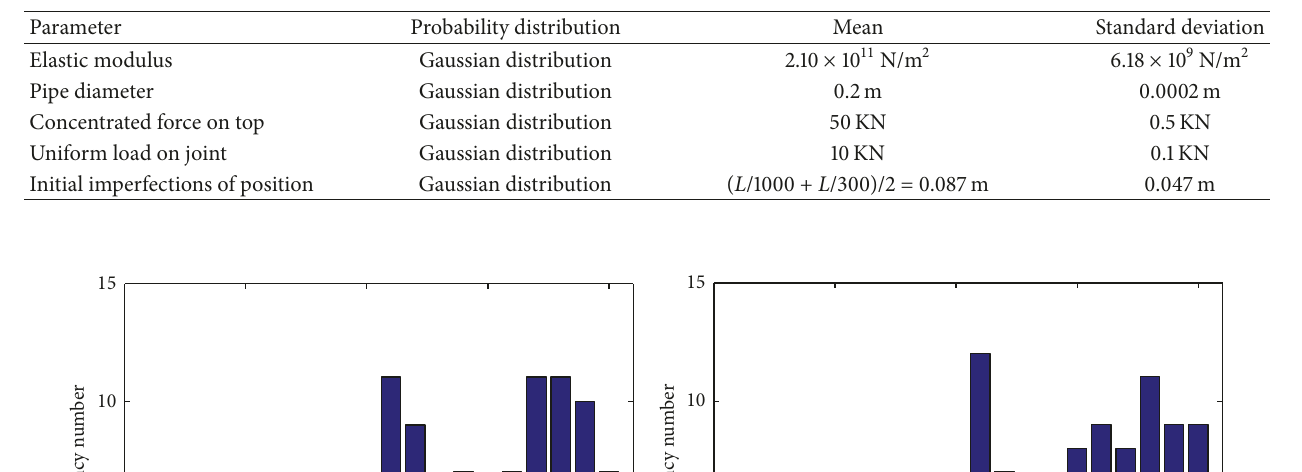
Table 2: Statistical parameter for sample structure.